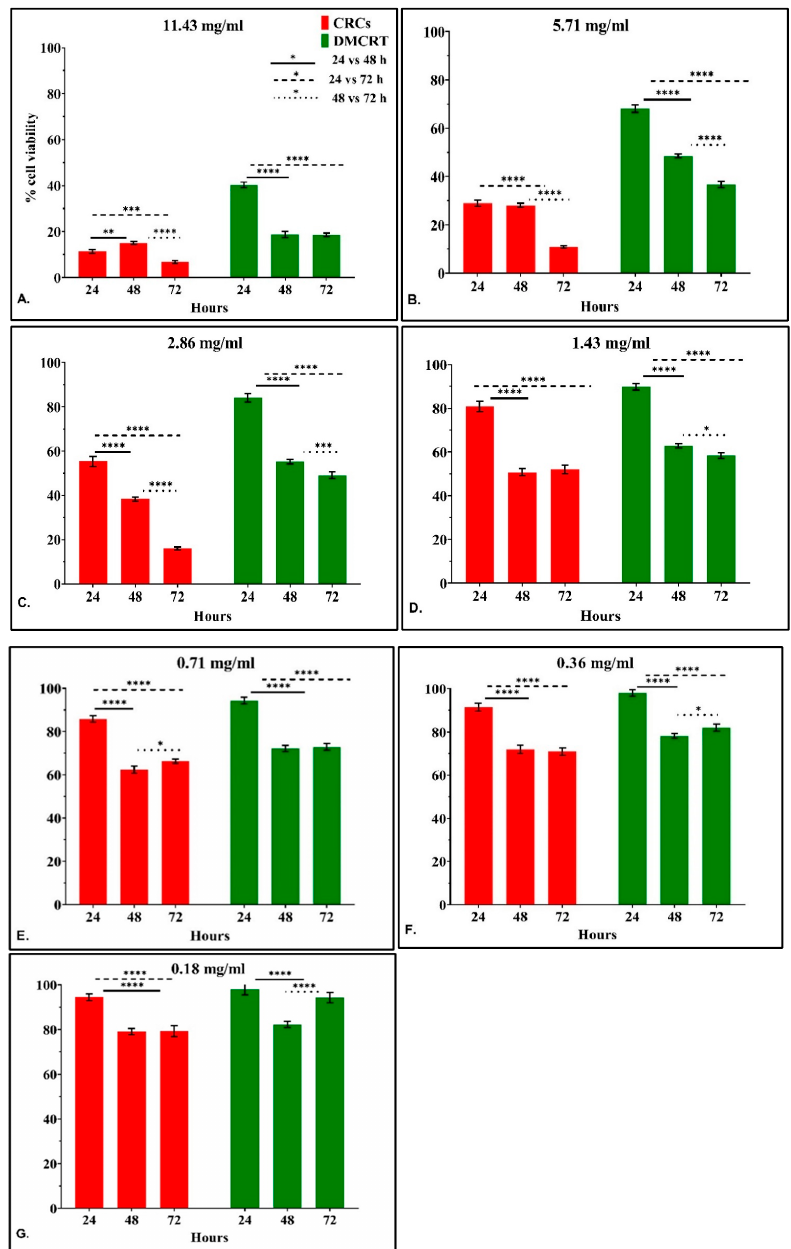
Figure 3. Time-dependent effect of CRCs and DMCRT on A172 cells. Time-dependent effect of CRCs and DMCRT at concentrations 11.429 mg/mL ( A ), 5.174 mg/mL ( B ), 2.857 mg/mL ( C ), 1.429 mg/mL ( D ), 0. 714 mg/mL, ( E ) 0.357 mg/mL ( F ), 0,18 mg/mL ( G ) Legend : CRCs : Crocins, DMCRT : dime- thylocrocetin. Asterisks (*) depict at least p < 0.05 significance level between control experiments and CRCs (* p < 0.05; ** p < 0.01; *** p < 0.001; **** p < 0.0001). Each value represents the mean ± S.D. of triplicate experiments. Based on the previous observations, we calculated the more efficient concentration of each phytochemical with respect to cell viability reduction velocity. Of note, the “speed” of alterations in cell viability is not identical to the effectiveness of a specific con- centration, but demonstrates how fast a specific concentration could alter cellular viability observed at 24 h to the viability at 72 h. The concentration of 2.857 mg/mL for both com- pounds, manifested such effectiveness. In particular, CRCs demonstrated the local maxi- mum at the 2.857 mg/mL concentration (Figure 4A). DMCRT manifested also a local max- imum at the 2.857 mg/mL concentration, yet with comparable “speeds” for the 1.429 and 5.174 mg/mL concentrations (Figure 4B). Of note, negative values indicate that viability is lower at 72 h as compared to 24 h. A low first derivative, is compatible with higher effec- tiveness of the compound for a specific concentration. In addition, as the derivative ap- proaches to zero, the more the compound exerted its effects from the first hours of treat- ment, whereas a derivative farther from zero, indicates that the compound requires more time in order to exert its effects. Thus, the effects of CRCs were changing dose-de- pendently for concentrations 0.09–2.86 mg/mL and thereafter CRCs’ action was already